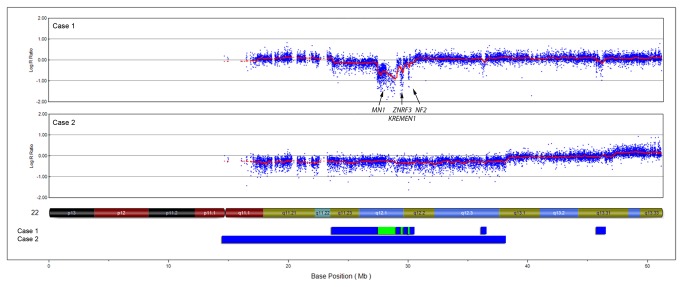
Recurrent deletions in osteoblastoma affect chromosome 22.By SNP array analyses, hemi-and homozygous deletions affecting chromosome 22 were found in cases 1 and 2. The upper parts of the figure display SNP array plots of the respective case and the lower part show a summary of the losses where blue and green bars represent hemi- and homozygous deletions, respectively. The locations of four homozygously lost genes implicated in bone formation and/or tumorigenesis are shown.